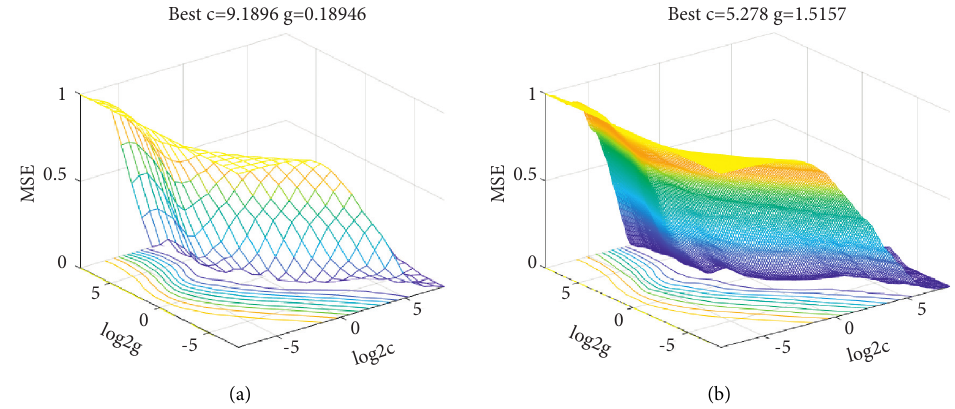
Figure 5: Hyperparameter selection results of the SVR model.